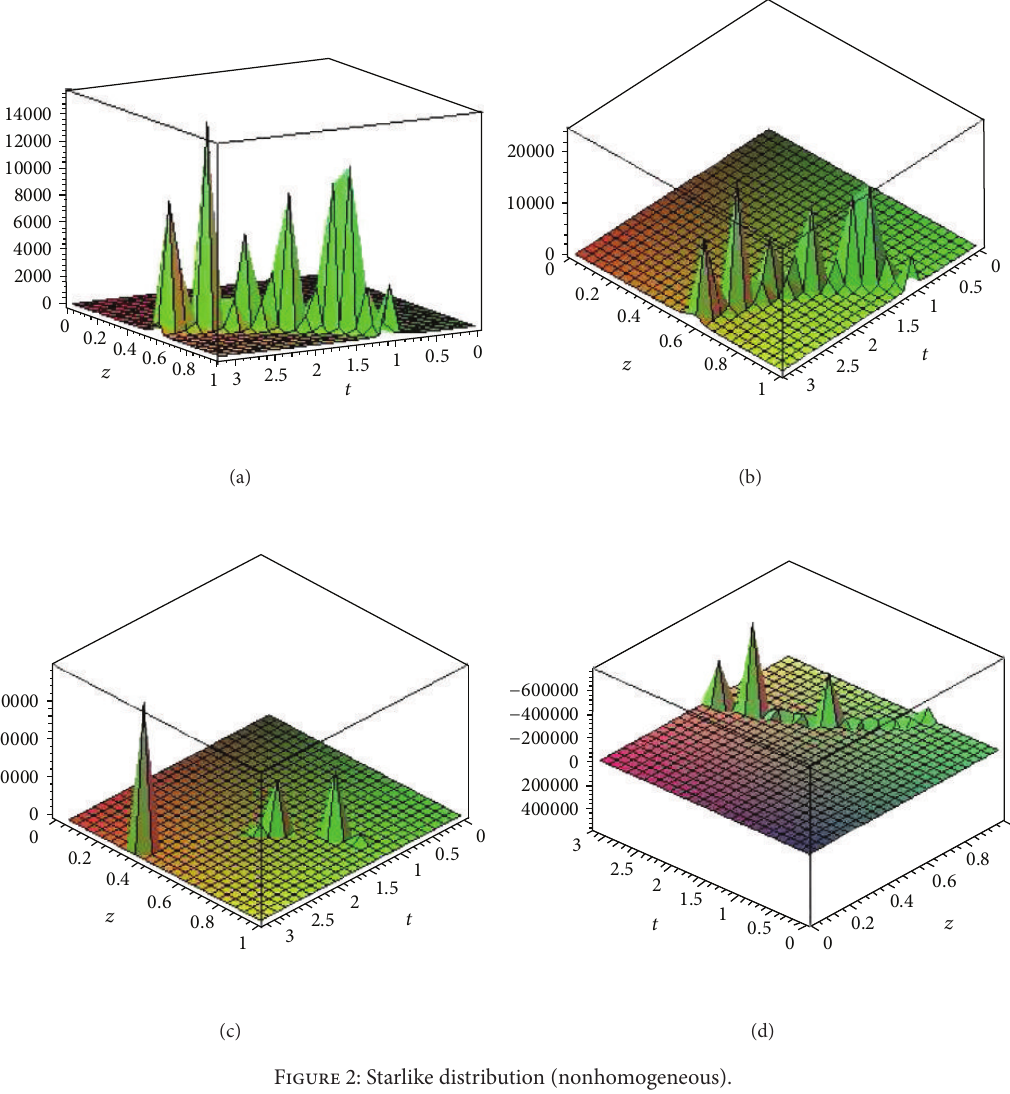
Figure 2: Starlike distribution